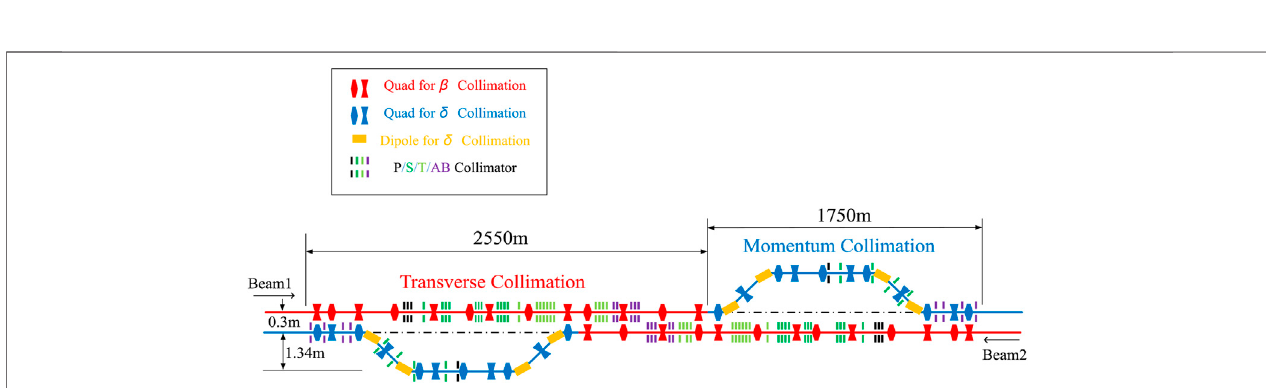
FIGURE 6 | Layout of the collimation insertion. P/S/T/AB denote primary collimator, secondary collimator, tertiary collimator and absorber.